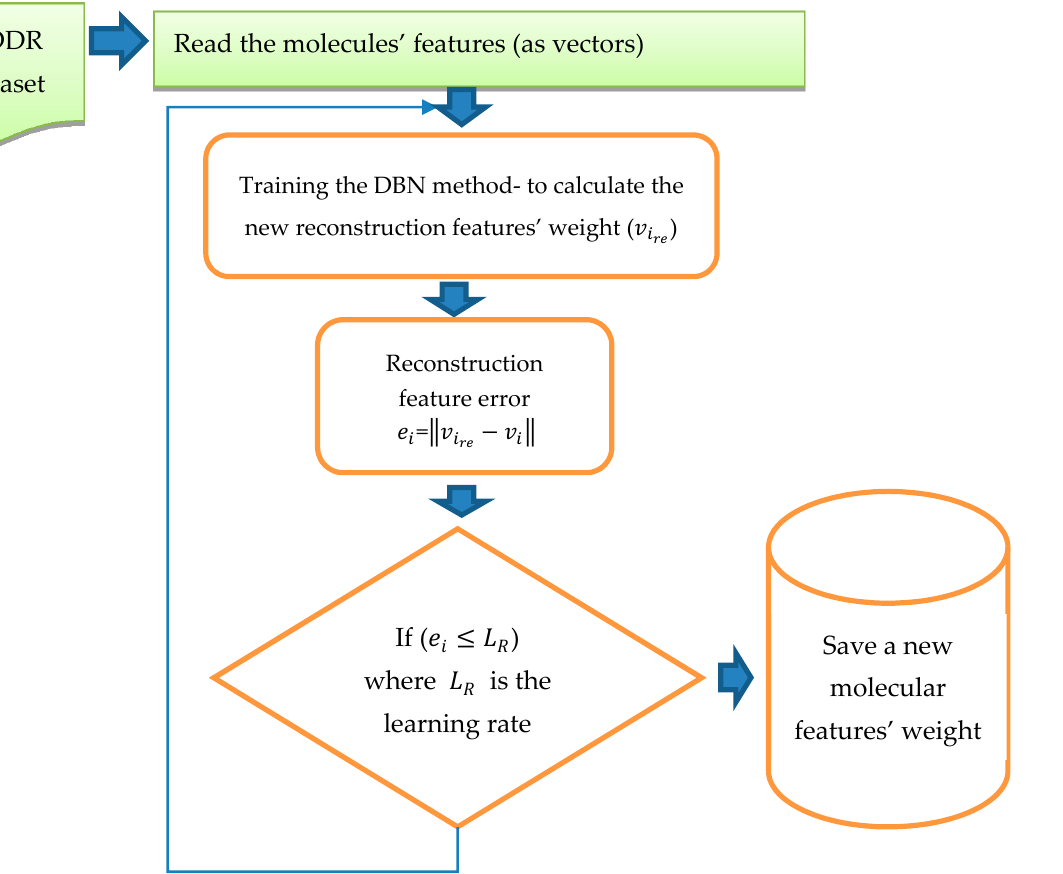
Figure 4. Reconstruction of features weight steps.